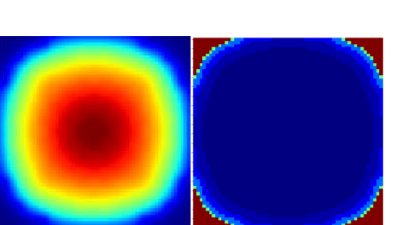
Figure 8. Adjoint Flux Profile from WIMS Deterministic Calculation (LEFT) And Generated Importance Map from Adjoint Flux Profile (RIGHT)